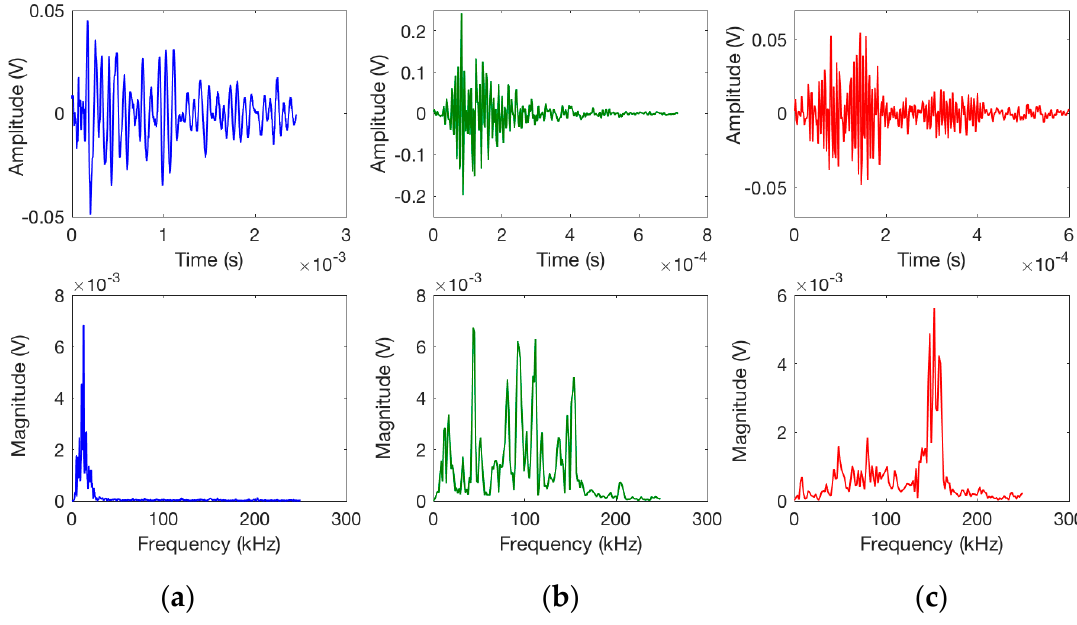
Figure 7. A representative signal in the time domain and frequency domain due to: ( a ) matrix cracking; ( b ) delamination; ( c ) debonding.